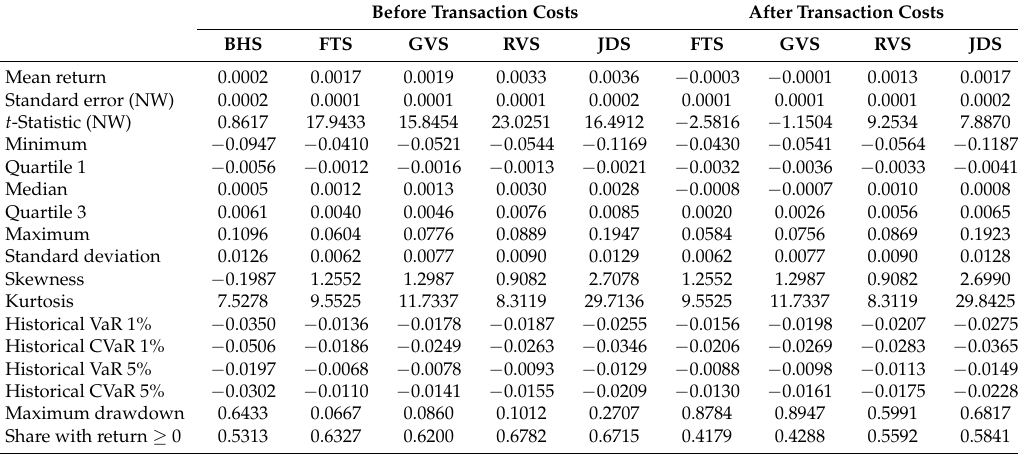
Table 3. Daily return characteristics and risk metrics for BHS, FTS, GVS, RVS, and JDS from January 1998–December 2015. NW denotes Newey–West standard errors with 1-lag correction and CVaR the conditional value at